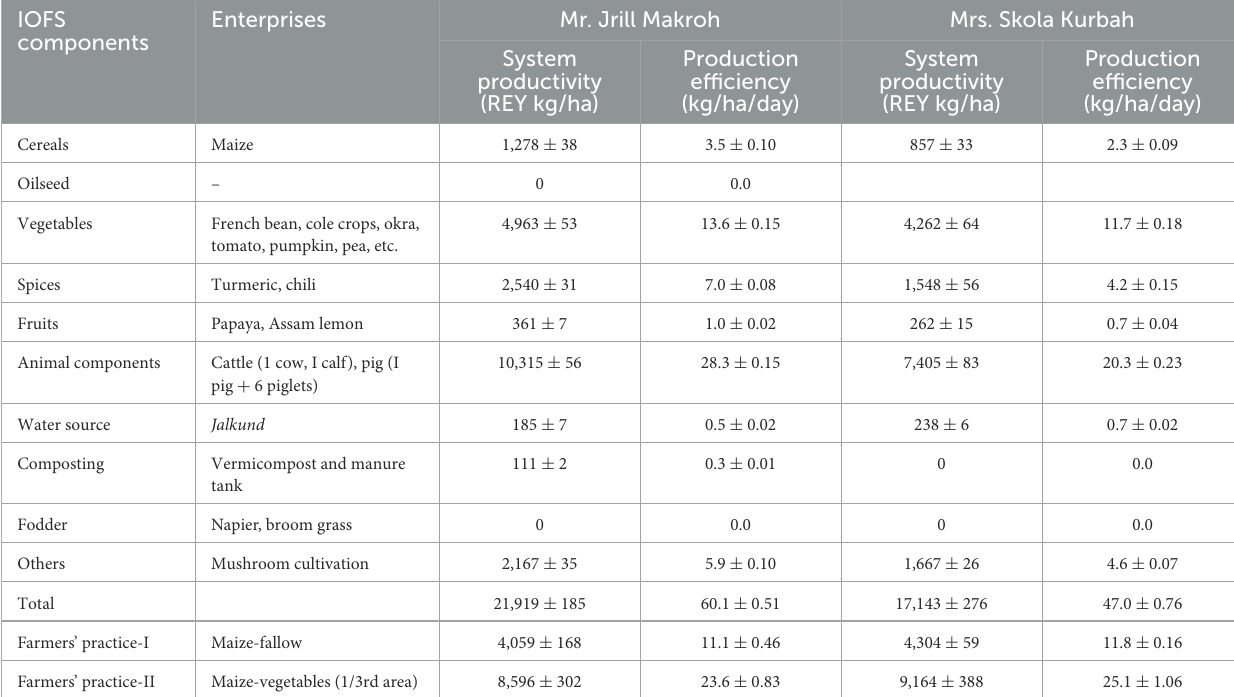
TABLE 2 Production of IOFS models of two farmers from adopted villages (average of 5